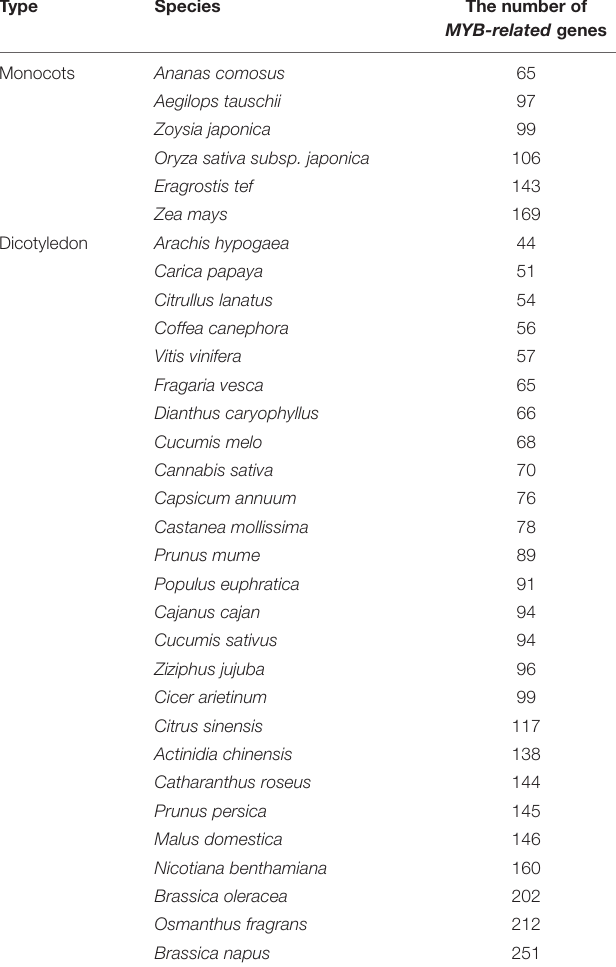
TABLE 1 | Comparison of the MYB-related gene family size between Osmanthus fragrans and other